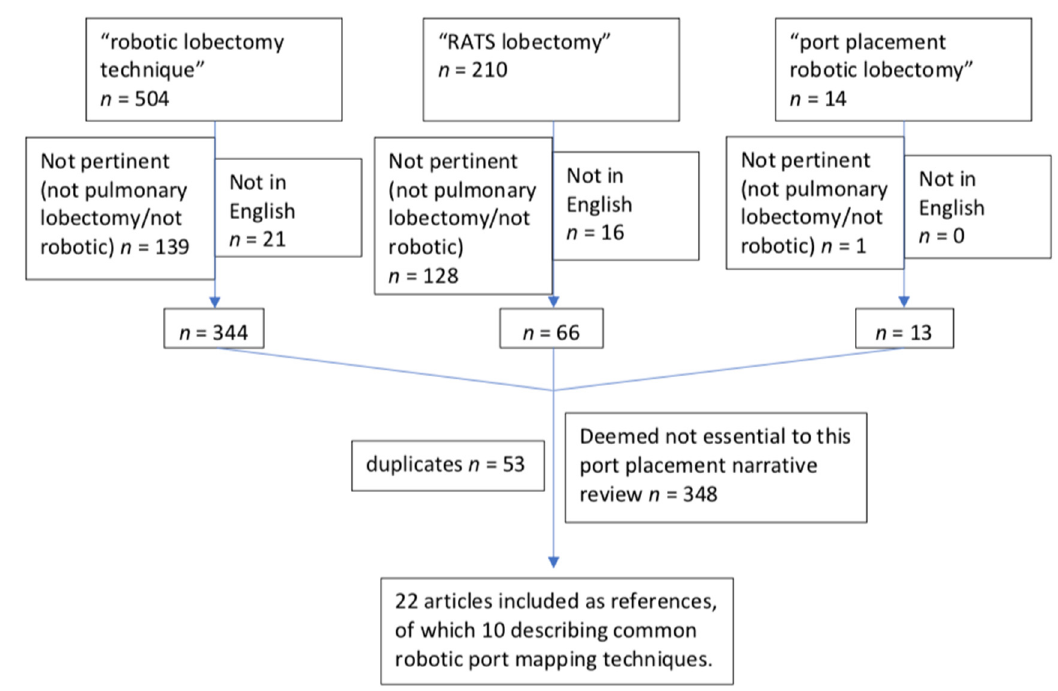
Figure 1. Flow chart summarizing the selection of included